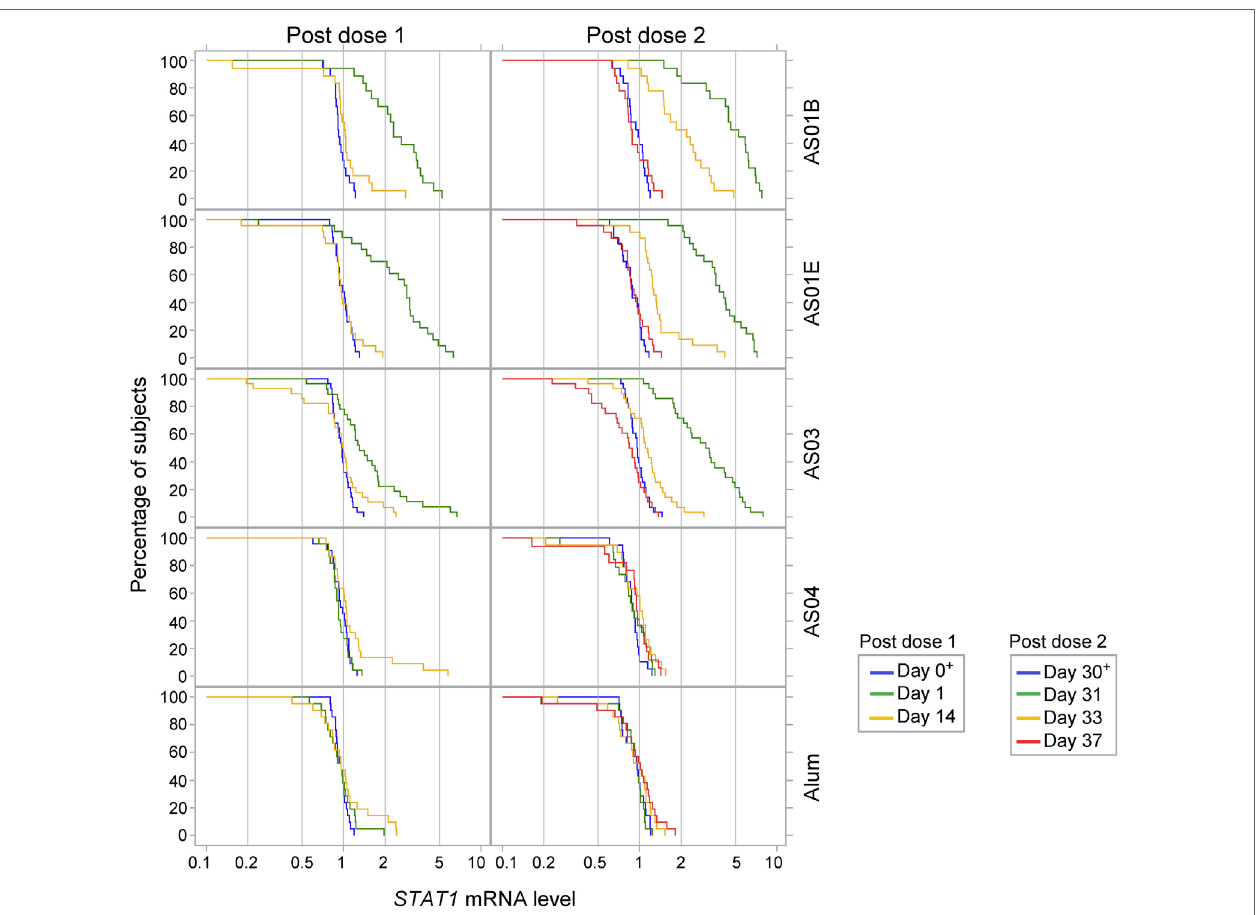
FiGUrE 5 | STAT1 expression. Reverse cumulative distribution curve of the STAT1 mRNA responses (in FC over day 0 or day 30 levels; N = 18, 23, 28, 22 and 21 in the AS01B, AS01E, AS03, AS04 and Alum groups, respectively) in whole blood after the first and second vaccine dose (left and right parts of the figure, respectively) are presented for the time points up to day